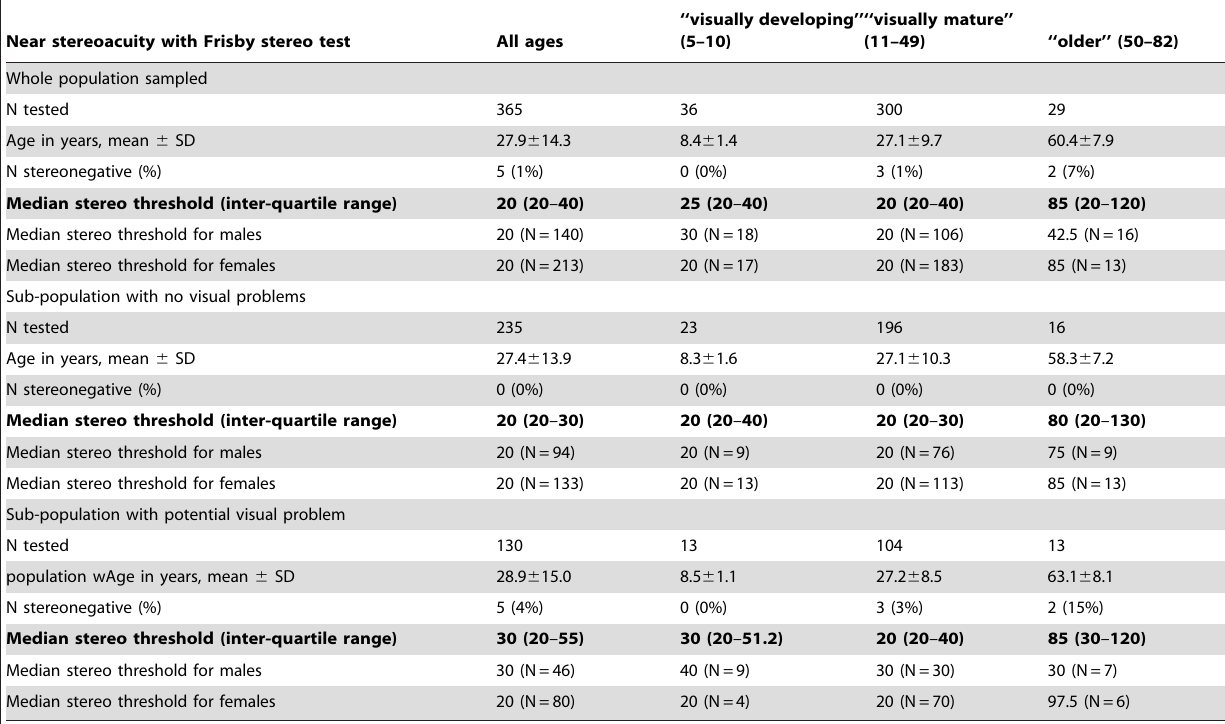
Table 1. Stereo thresholds on the Frisby test for different groups.